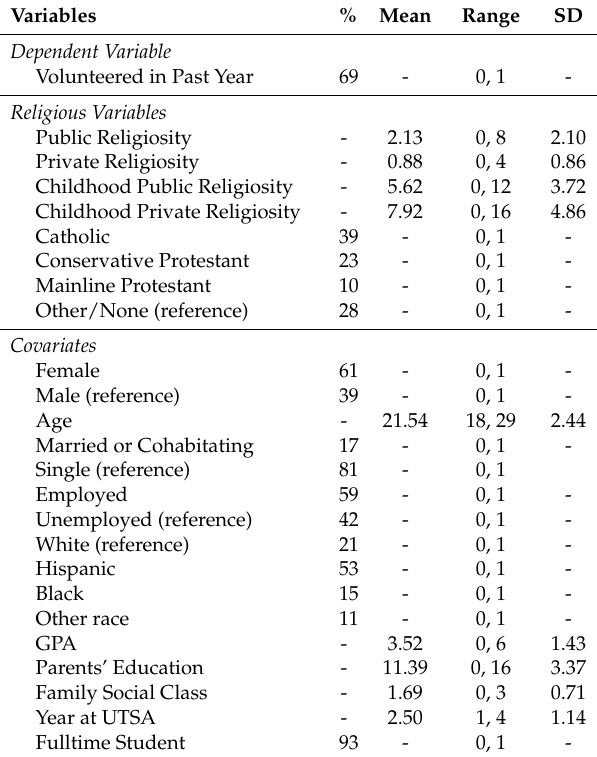
Table 1. Sample characteristics ( n =